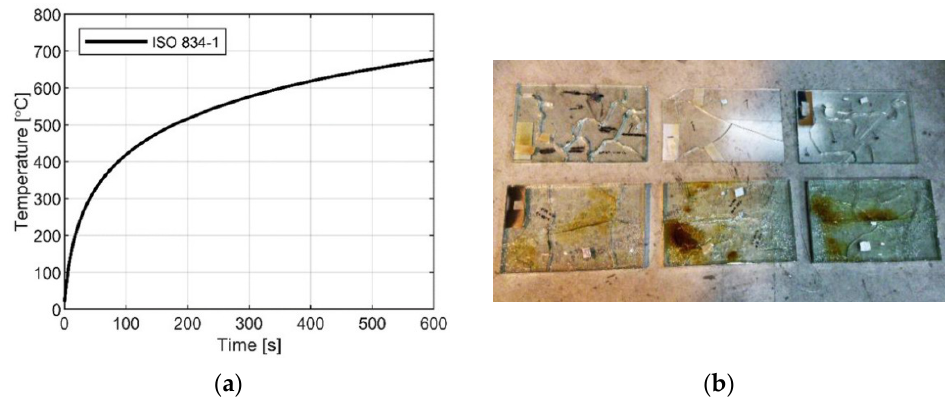
Figure 2. ( a ) Conventional time–temperature curve according to ISO 834-1 [69] and ( b ) example of non-uniform thermal exposure (after test; figure reproduced from [70] under the terms and conditions of CC-BY copyright license agreement).